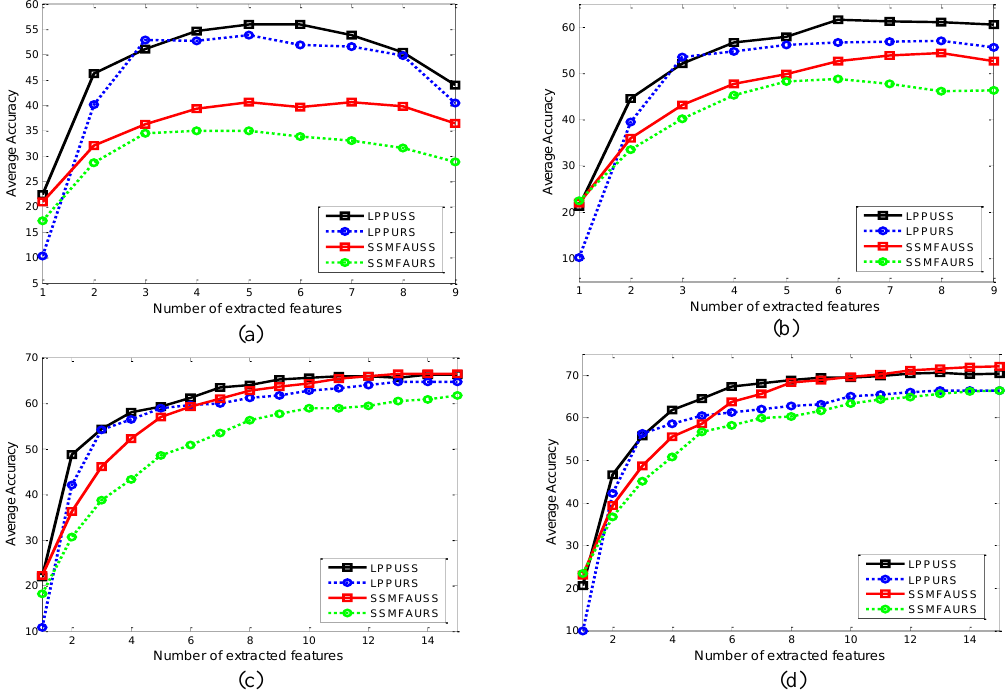
Figure 1. Average accuracy versus the number of extracted features for IP dataset, (a) GML classifier, 10 training samples, (b) GML classifier, 15 training samples (c) SVM classifier, 10 training samples and (d) SVM classifier, 15 training